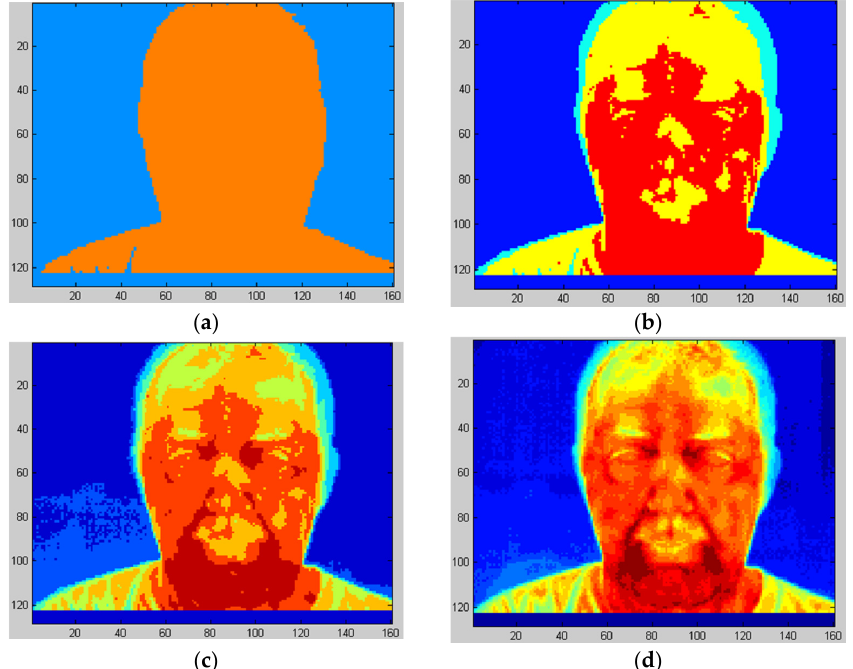
Figure 3. Isothermal regions obtained by dividing the histogram into ( a ) two regions, ( b ) four regions, ( c ) eight regions and ( d ) twenty regions.